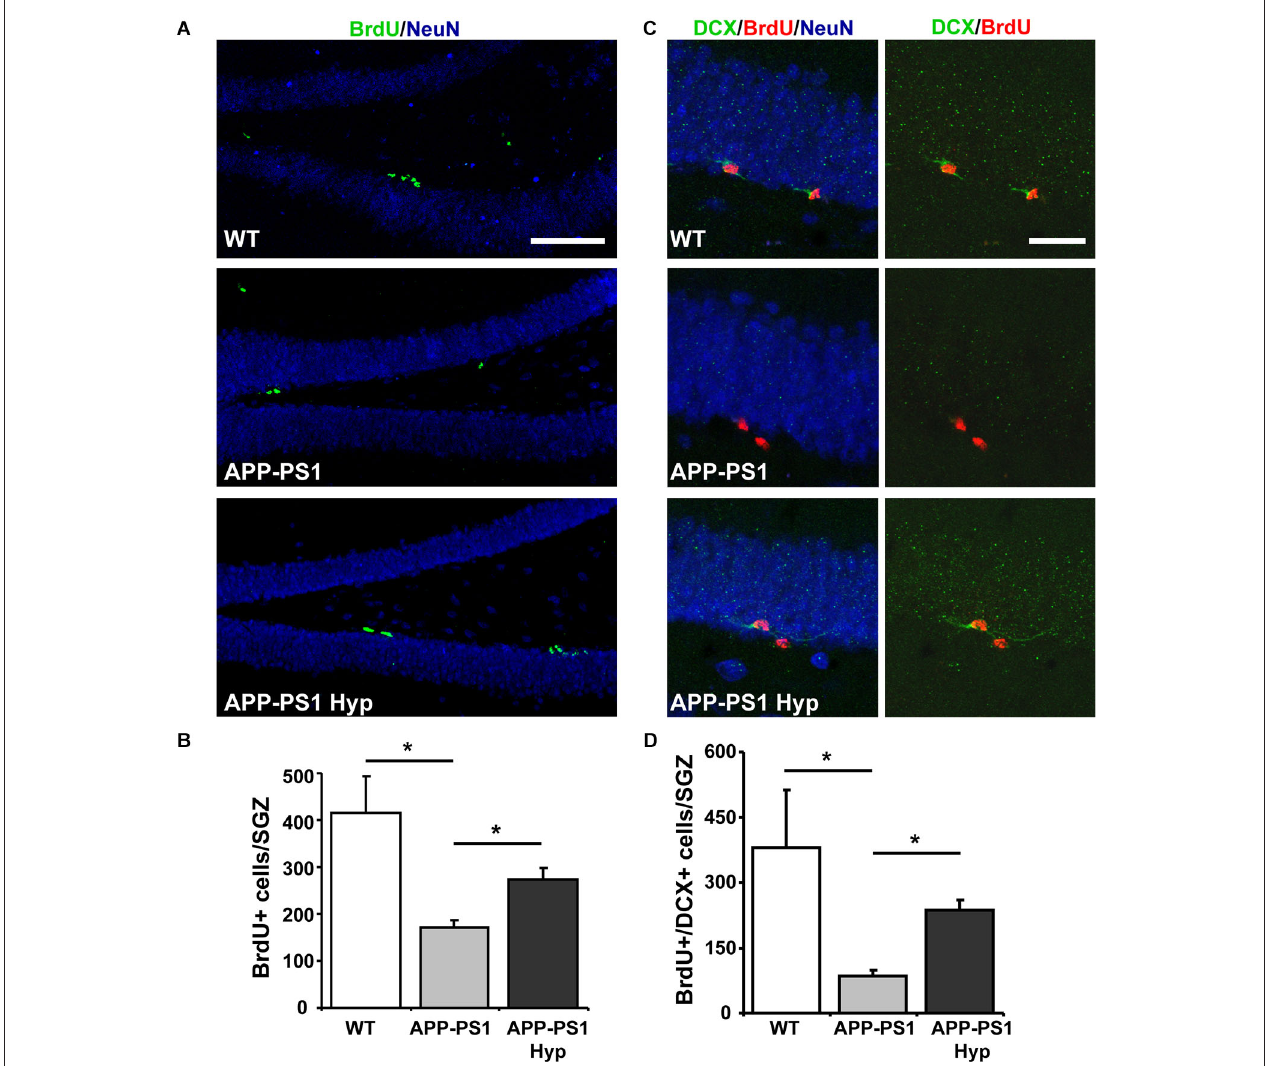
the SGZ of all experimental groups. (C) Representative double labeling of BrdU and DCX in the same animals. Scale bar: 20 µ m. (D) Total number of BrdU + cells also positive for DCX (BrdU + /DCX + ) in the hippocampus of all experimental groups. Bars represent mean ± S.E ( n ≥ 3 mice). * p <